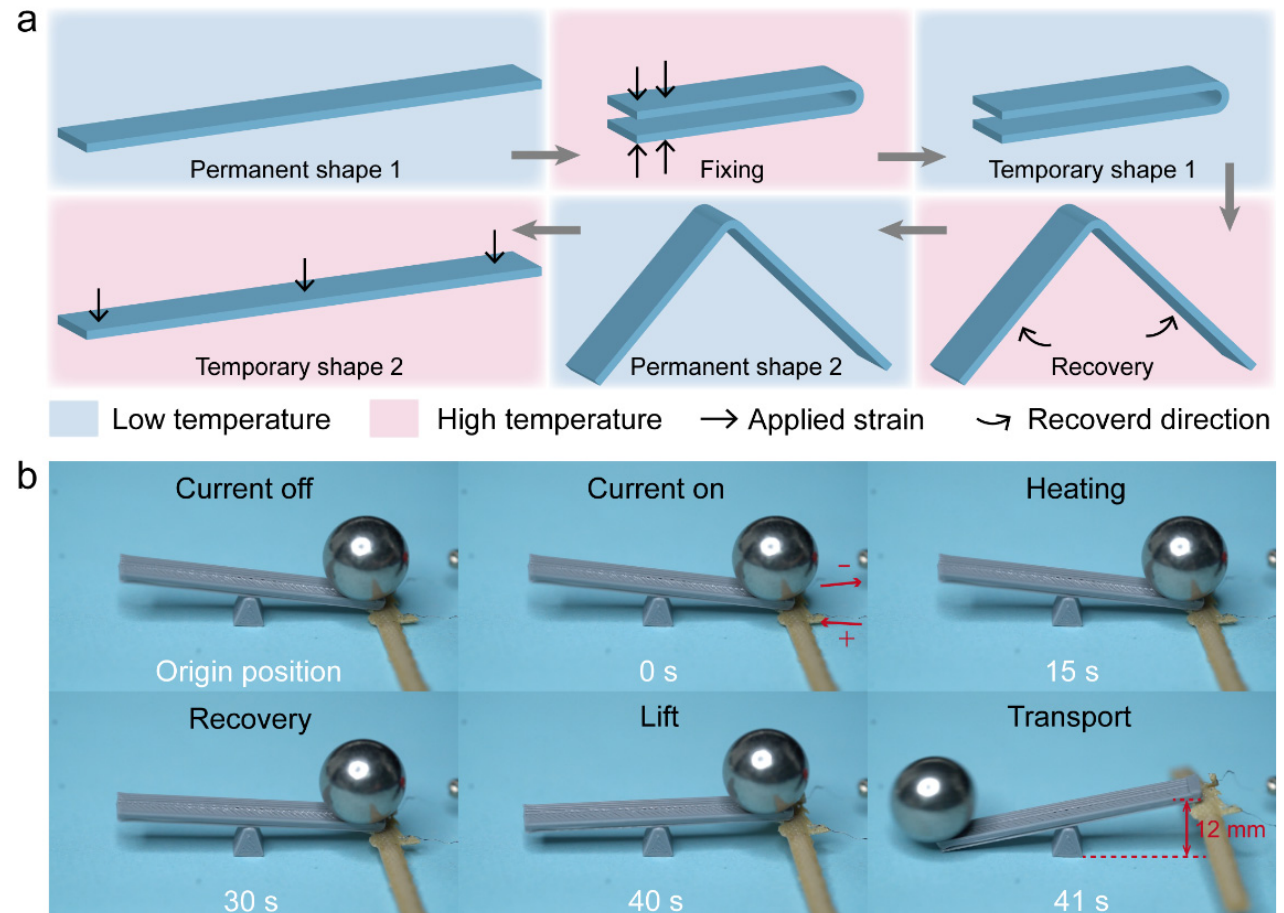
Figure 8. Weight transport by shape memory PEEK. ( a ) The programming of actuated PEEK sample. ( b ) The experiment process of weight transport.